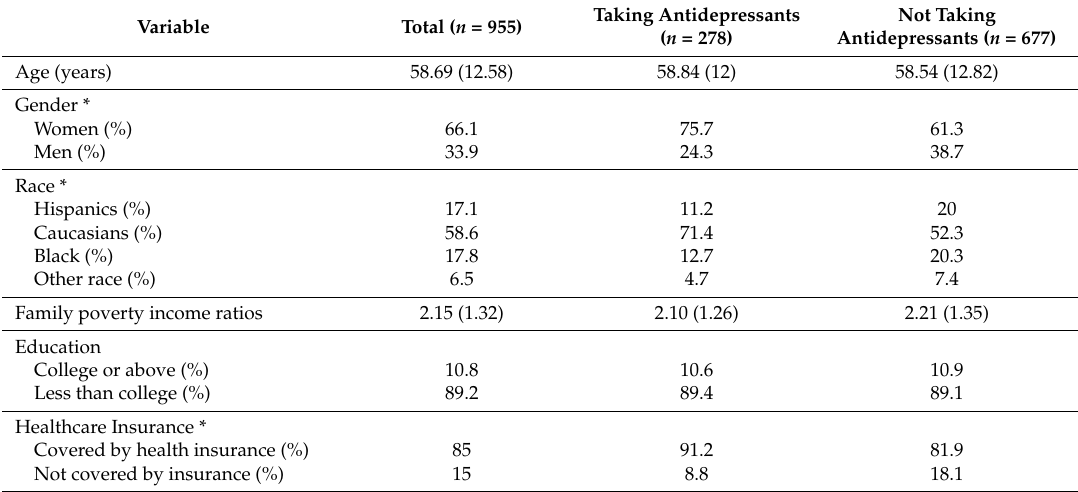
Table 2. Sociodemographic Characteristics of Patients with Type 2 Diabetes and Depression